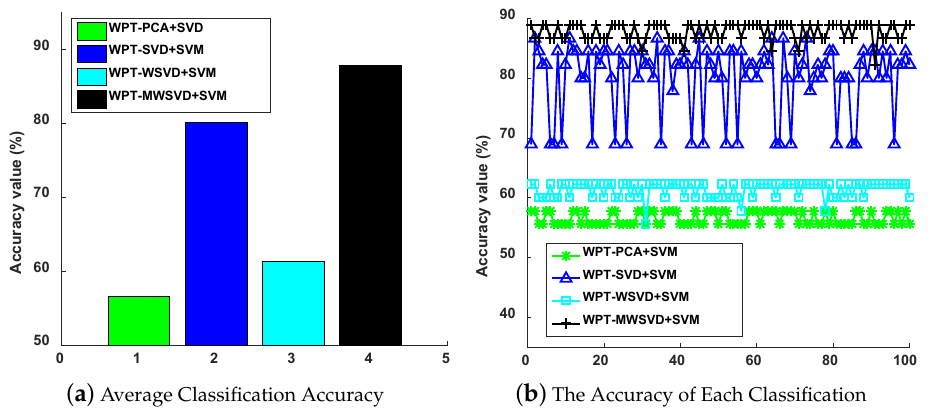
Figure 9. The average classification accuracy of 100 runs ( a ) and each classification accuracy ( b